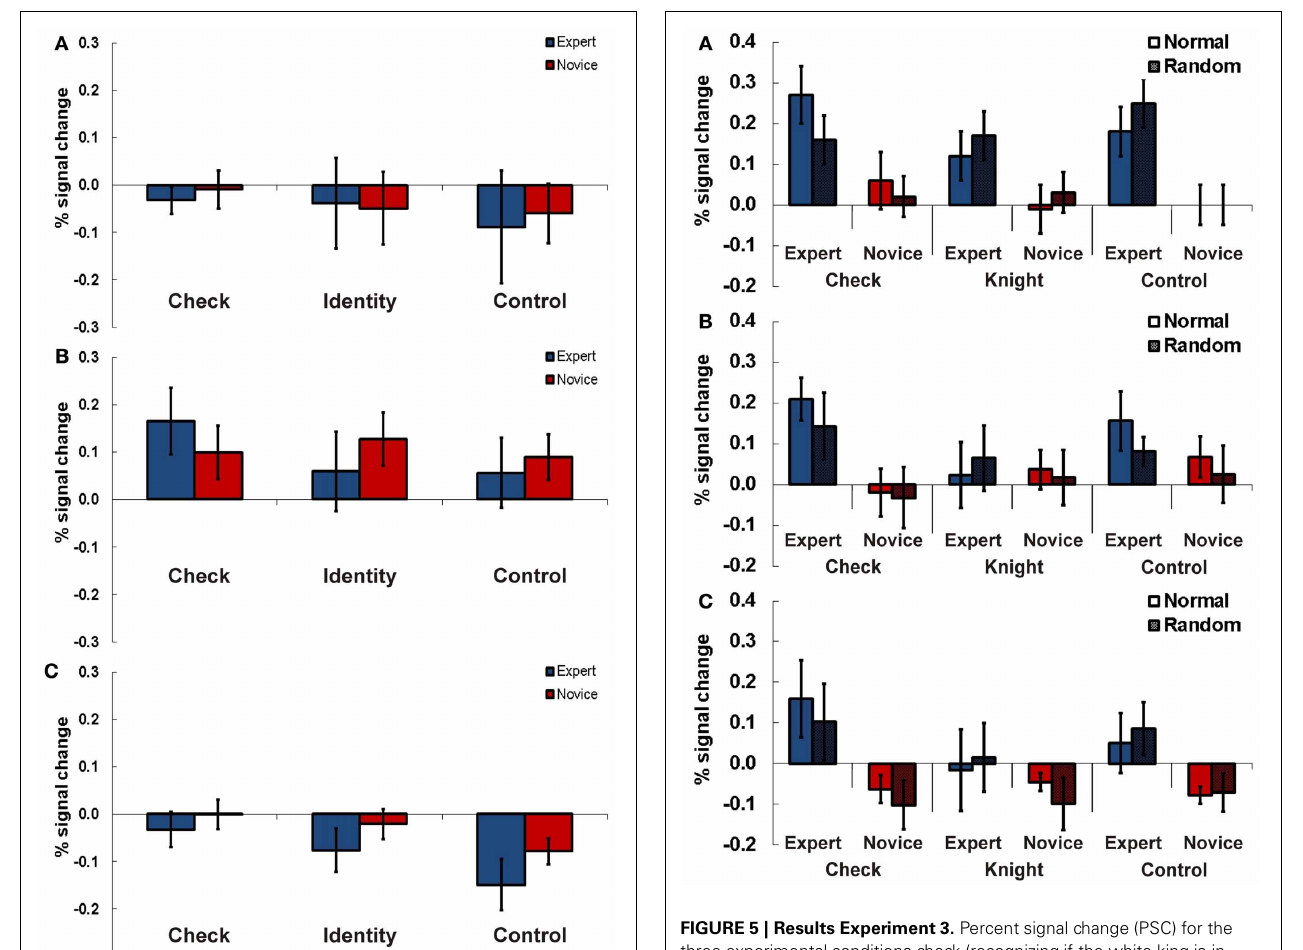
novice) x task (check vs. knight vs. dot) x position (normal